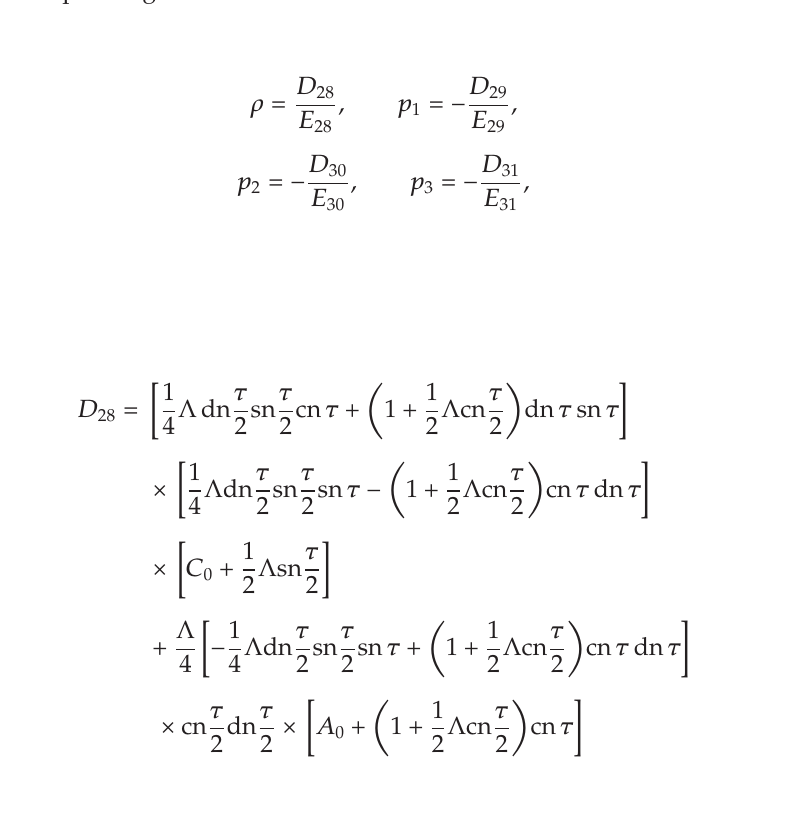
The corresponding EoS takes the